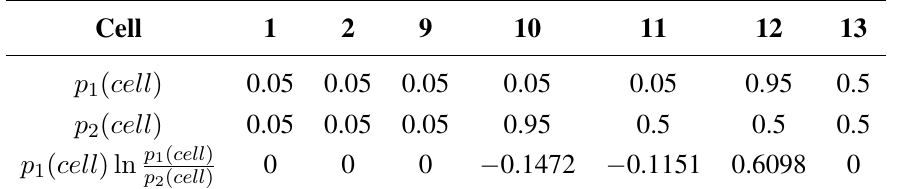
( cell ) = p ( m ) , 1 S k ij